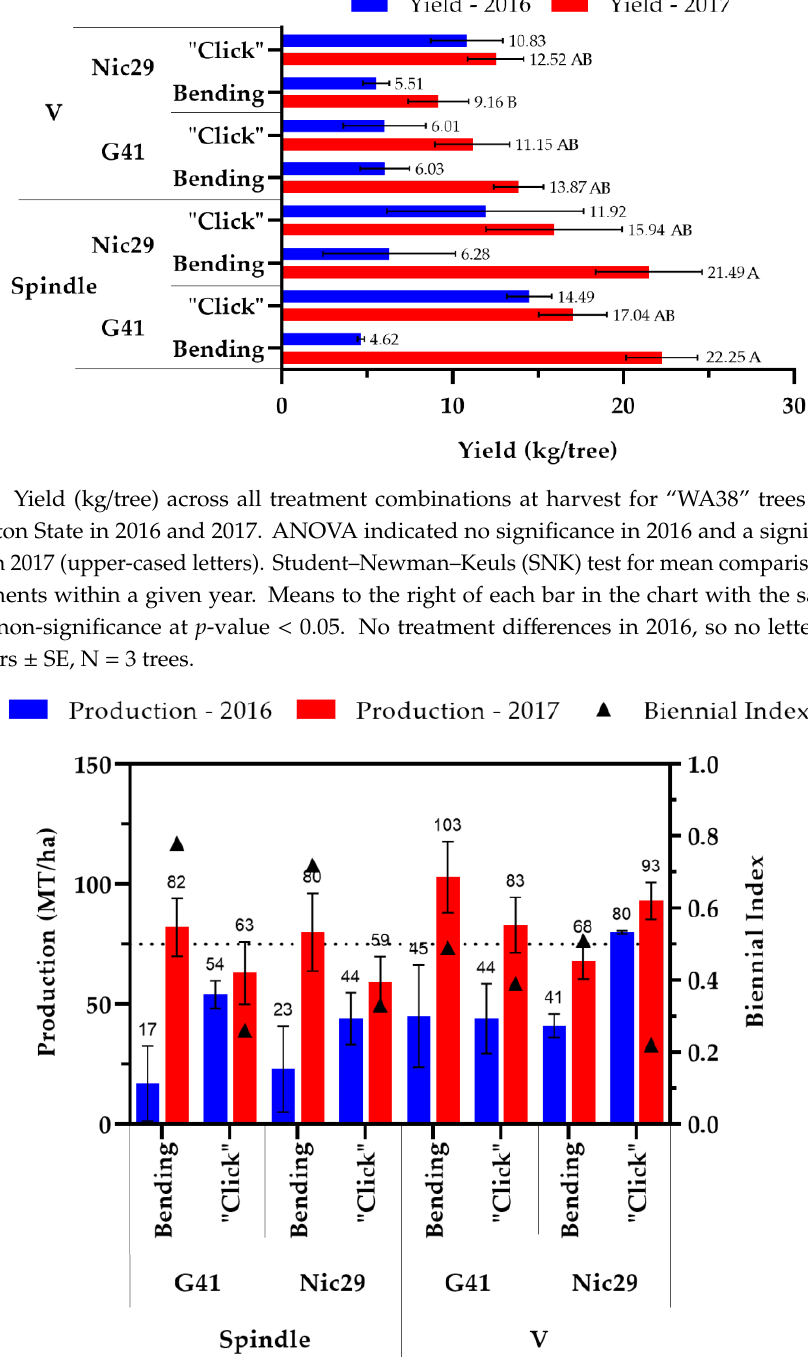
Figure 5. Yield (MT/ha) and biennial index (I) across all treatment combinations at harvest for “WA38” trees grown in Washington State in 2016 and 2017. ANOVA indicated no significance in 2016 and 2017 for calculated production. Biennial index (black triangles) from Hoblyn et al. [53] comparing fruit count in 2016 and 2017. The classifications are quantified as: I = 0.90–1.00 = Strongly Biennial, 0.50–0.89 = Biennial, 0.10–0.49 = Consistent, 0.00–0.09 = Strongly Consistent. Black dashed line indicates the “biennial” classification threshold at 0.50. Errors bars ± SE, N = 3.